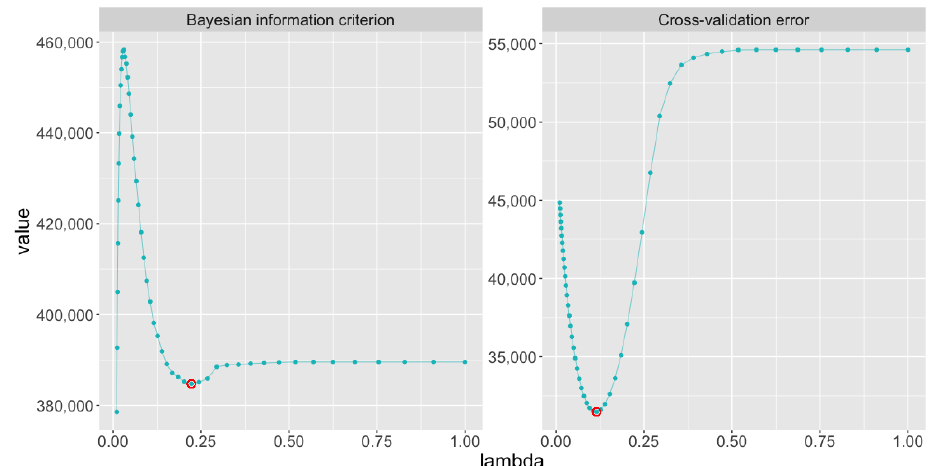
Figure 7. Left panel: values of BIC obtained for glioblastoma datasets with K = 3, p = 483 and n 1 = 40, n 2 = 77, n 3 = 80 over the uniform in log-scale grid of 50 parameters of λ from 0.01 to 1. Right panel: CV error obtained with the same settings. Red circles denote estimated optimal λ OPT